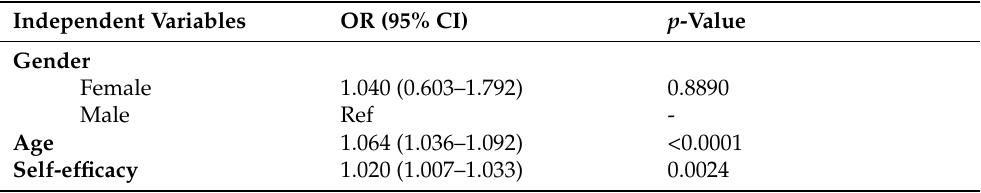
Table 4. The final model of factors associated with the odds of taking measures against mosquitoes. Independent